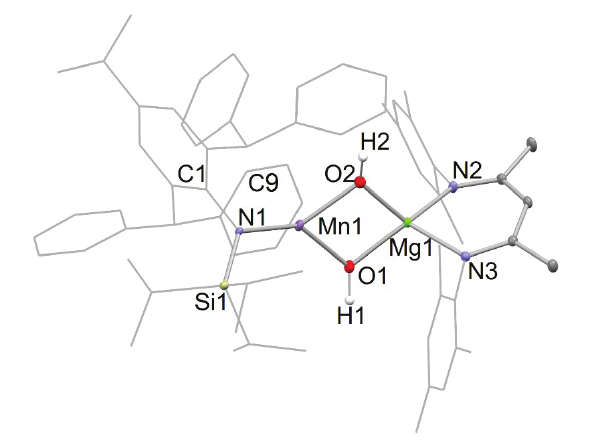
Figure 2: Thermal ellipsoid plot (20% probability surface) of the molecular structure of 3 (hydrogen atoms, except hydroxy protons, omitted; Ar † , Mes and isopropyl groups shown as wireframe for